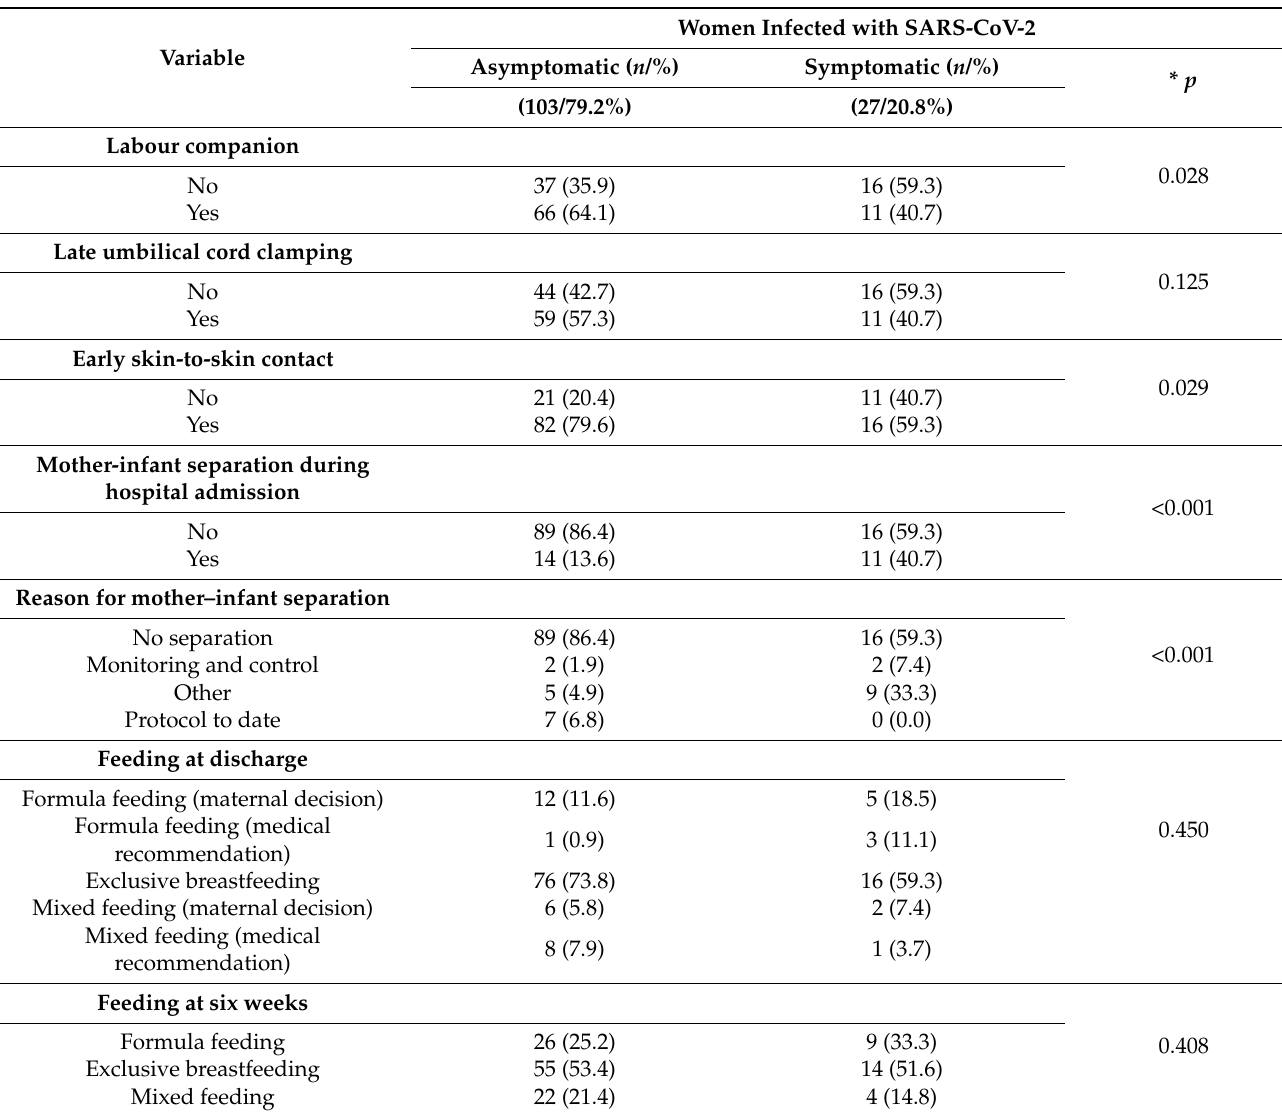
Table 4. Obstetric–neonatal general care of the study